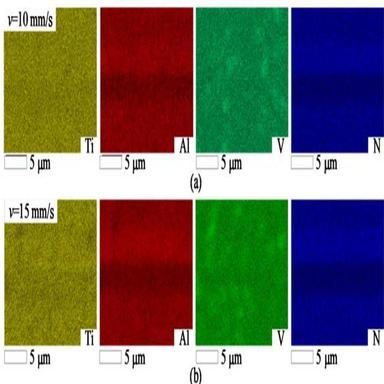
The EDS mappings of the residual scratches corresponding to (a) d), and (b) f).